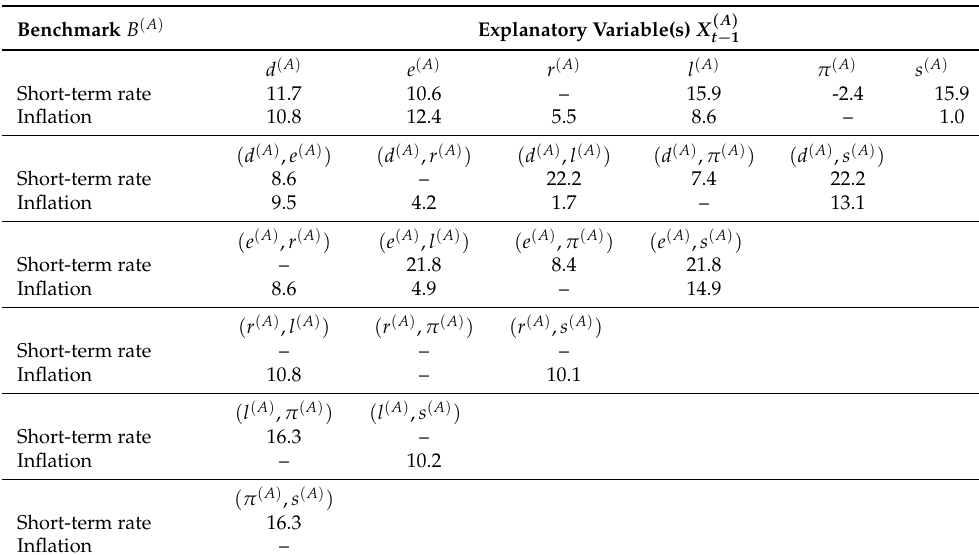
Table 4. Predictive power (%) for the five-year excess stock returns Z prediction problem defined in (8). For additional notes, refer to Table 3.